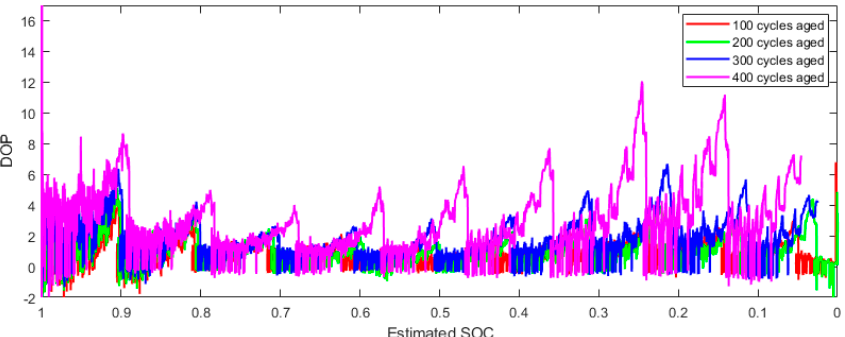
Figure 12. The DOP-SOC curves in the aging process.